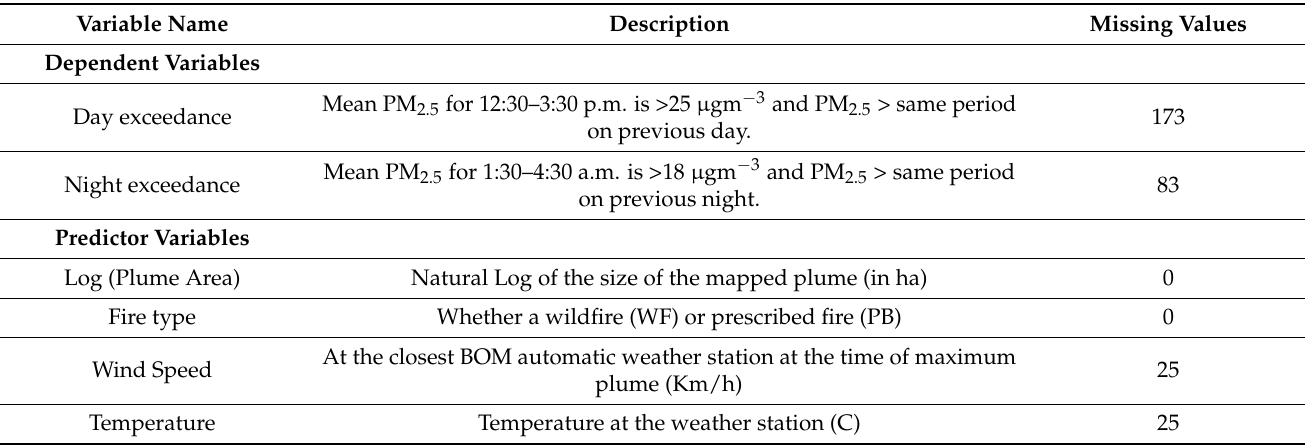
Table 1. Variables used in the statistical